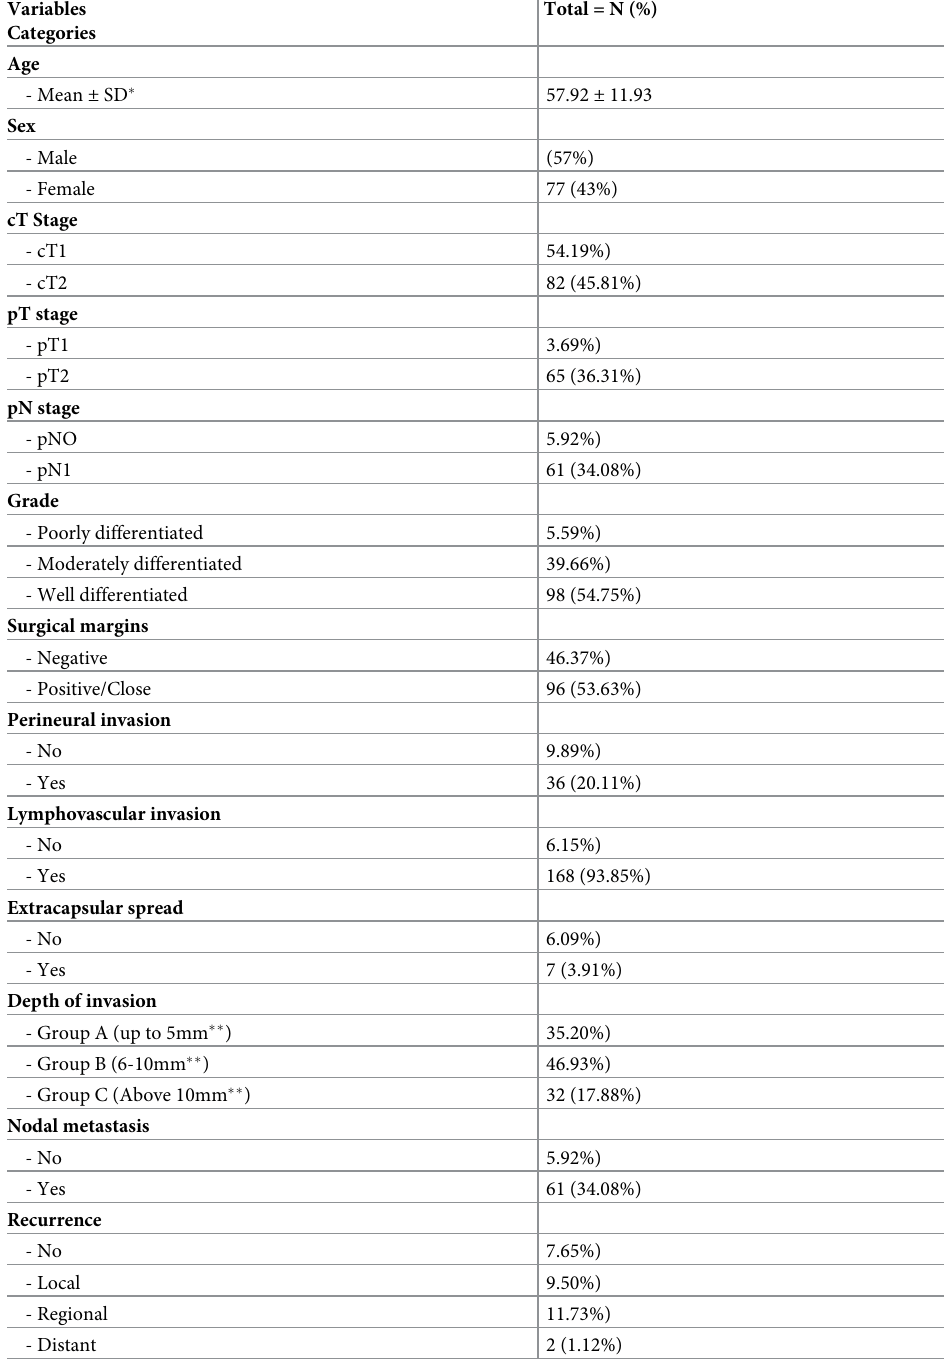
Table 1. Baseline characteristics of 179 squamous cell carcinoma